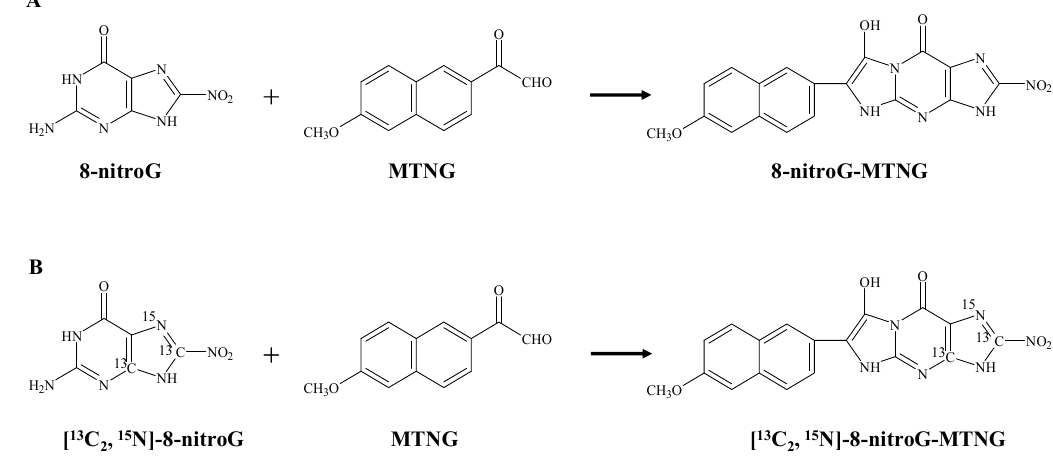
Figure 5. Derivatization of unlabeled 8-nitroG and [ 13 C 2 , 15 N]-8-nitroG with MTNG to form 8-nitroG- MTNG ( A ) and [ 13 C 2 , 15 N]-8-nitroG-MTNG ( B ).